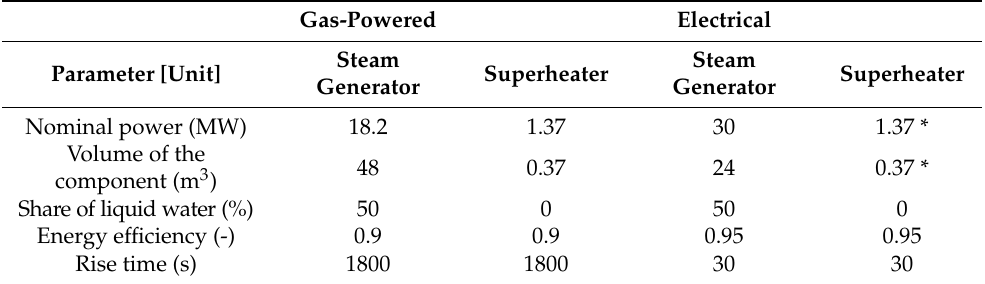
Table 1. Parameterization of the steam generation.